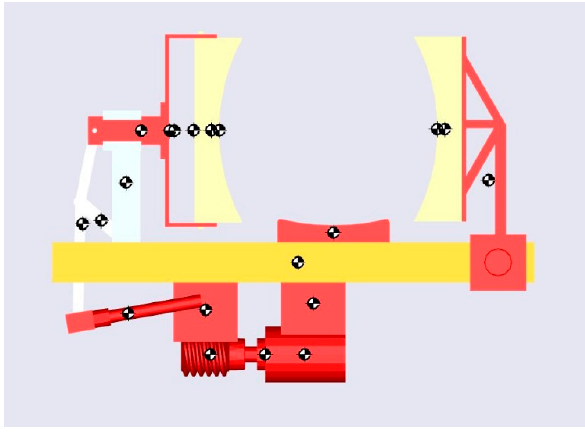
Figure 5. A frame of SimMechanics (version 1.0, MathWorks, Natick, MA, USA) simulated animation of the knee-loading device for proposed design.